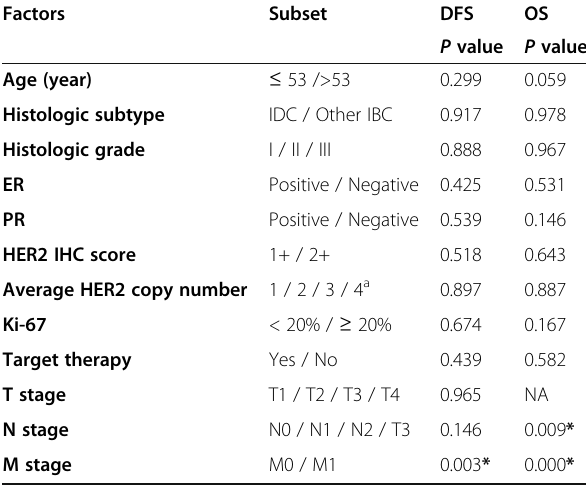
Table 3 Univariate analysis of prognostic factors affecting DFS and OS in HER2 FISH-equivocal